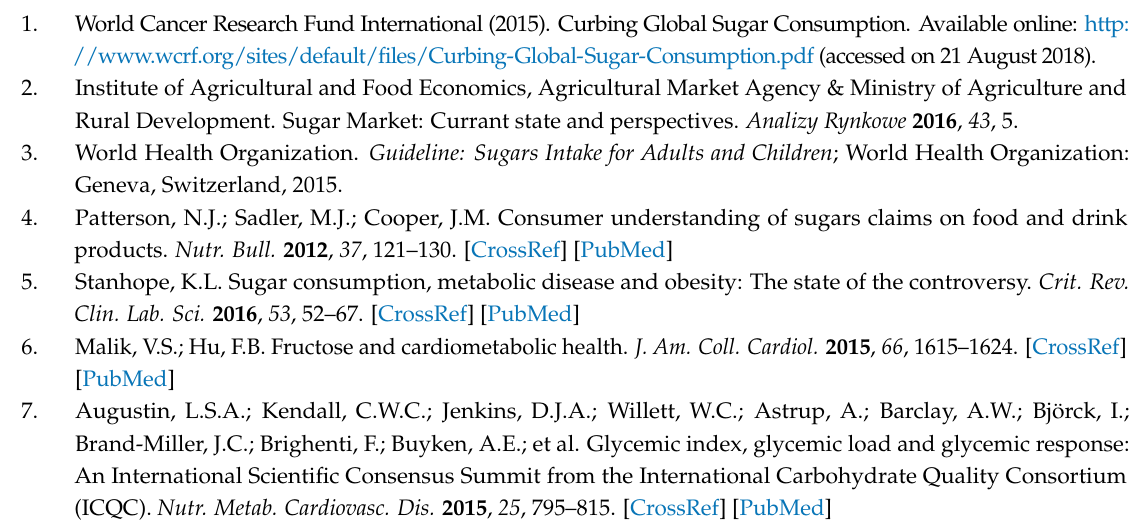
Table S1: Mean daily diet nutritional value (with 95% confidence interval) of women groups: “restricting sugar” (RS) and “not restricting sugar” (nRS) during the week, weekdays and the weekend ( n = 192): crude and adjusted